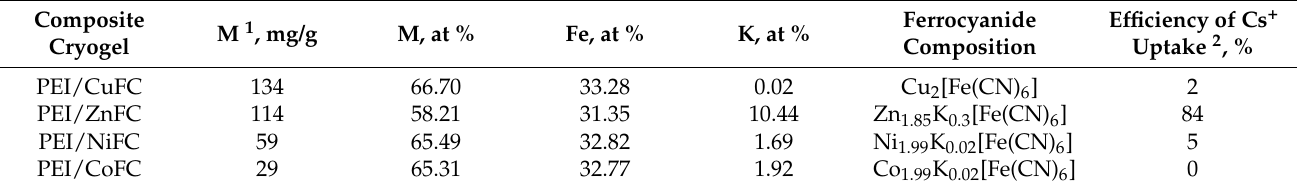
Table 1. Elemental analysis (SEM-EDX data) and sorption efficiency of the composite cryogel containing transition-metal ferrocyanides